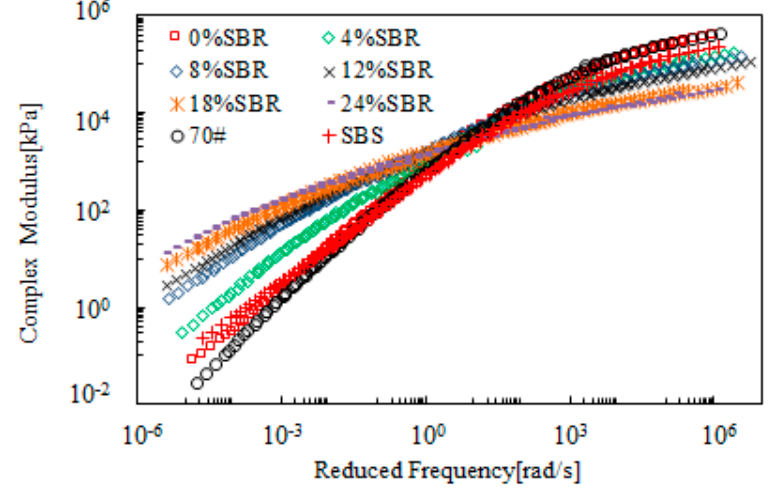
Figure 7. Complex modulus master curves of SBR-modified emulsified asphalt.